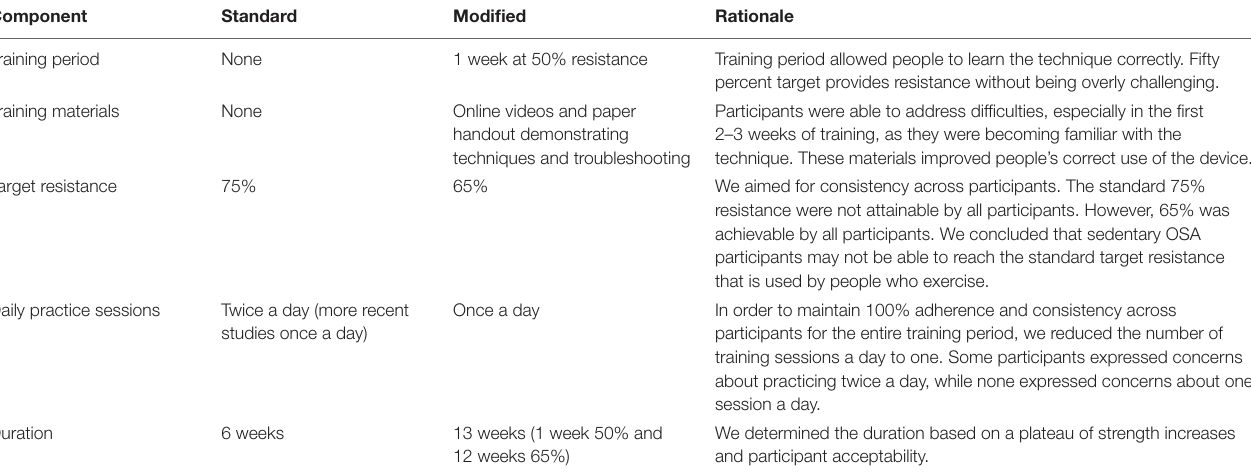
TABLE 1 | Protocol modifications after testing five OSA participants.